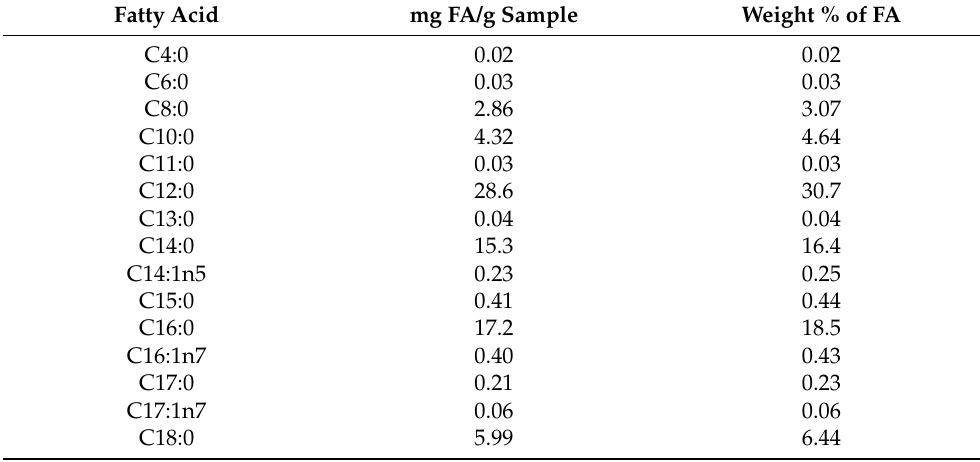
Table 3. Quantitative and qualitative fatty acid profiles of the original vanilla shake